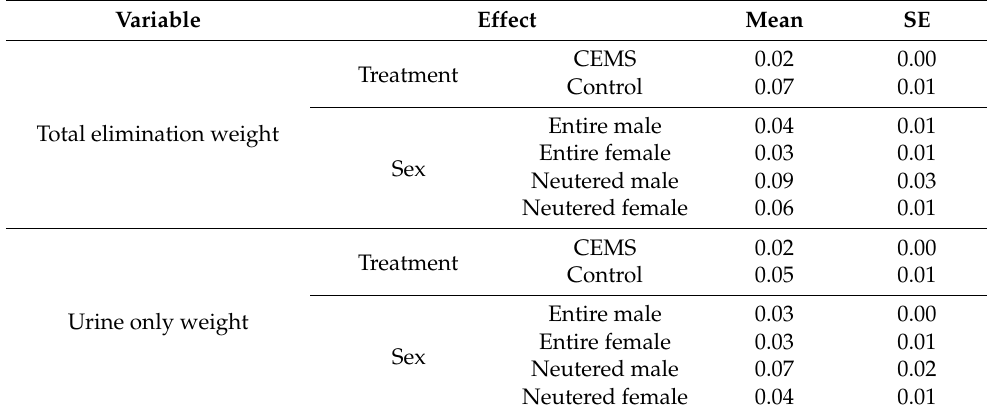
Table 2. Means and standard error of the total elimination weight in kilograms and the urine only weight in kilograms, according to treatment and